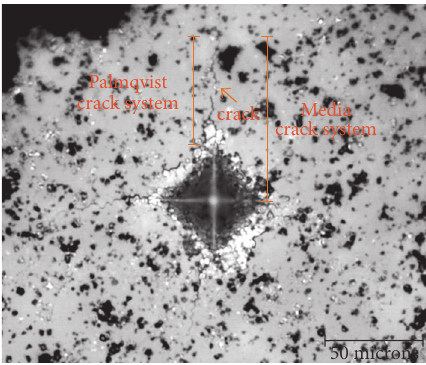
Figure 1: Vicker hardness test using a load of 1.96 N on ferroelectric ceramic